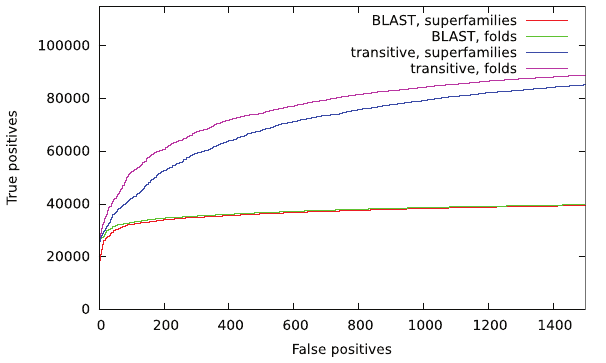
Figure 2. ROC curves of hits from SCOP 40 to itself. Hits to the same SCOP classification are considered true positives, hits with different classifications are considered false positives.